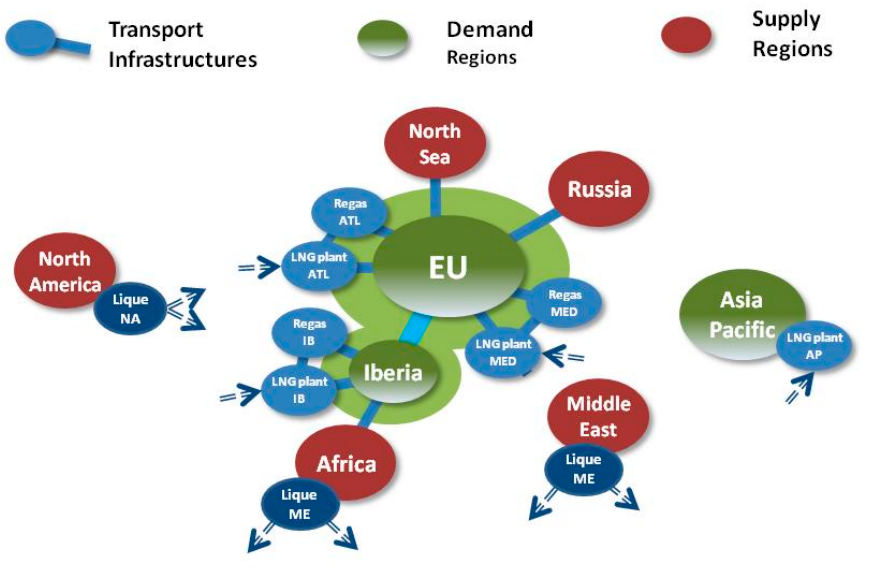
Figure 2. Model nodes and arcs.